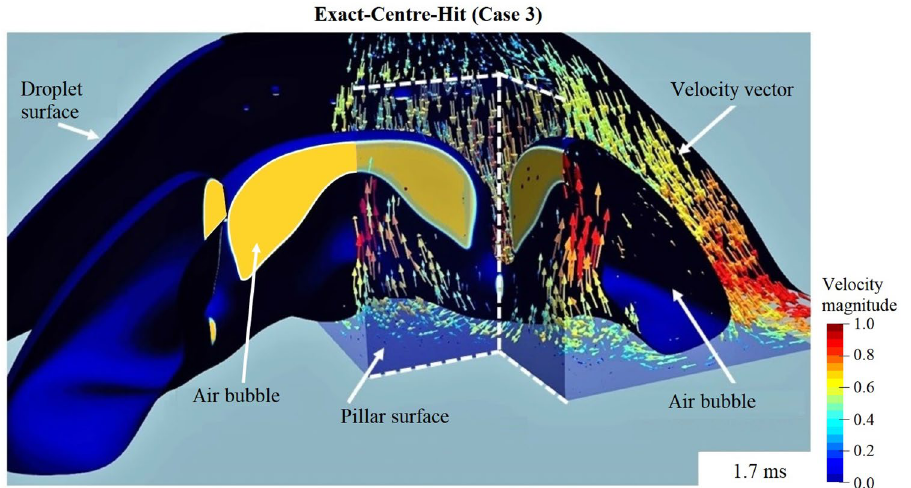
Figure 6. 3D velocity vector field of the droplet at one corner of the pillar. The colour of the velocity vector depicts the dimensionless velocity magnitude | V | / U 0 . Results from a D = 2 mm isopropanol droplet, impacting onto a 1 mm × 1 mm × 1 mm cubic pillar embedded on a flat surface. The collision point lies at the centre of the pillar top. The contact angle is 0 ◦ , satisfying the full-wetting condition. We = 159 and Re = 1119 . The edges of a quarter of the cubic pillar are outlined with white dashed lines for visualisation purpose. Both the droplet and the bubble surface (interface between the air and the liquid) are denoted by navy blue; transparent blue of the pillar indicates the wetted area on the pillar surface; the yellow area is part of the air bubble and indicates the unwetted area on the pillar surface. The velocity vector field as well as the surface of the droplet, the air bubble and the pillar were generated with free software Paraview 5.9.0 (www. parav iew.